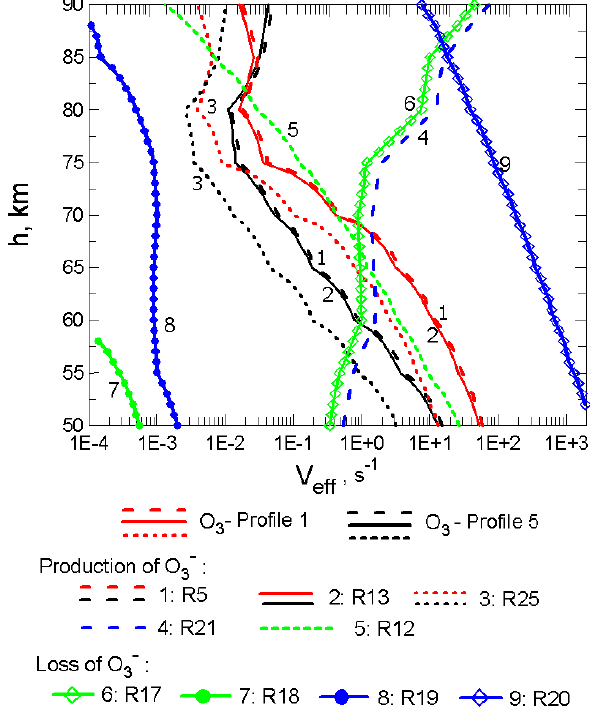
Fig. 3. Height profiles of the efficiencies of reactions for the O − ion production and loss. Red and black lines correspond to ozone profiles 1 and 5, respectively, in Fig. 1. See text Sect. 3.1 for the various reaction paths